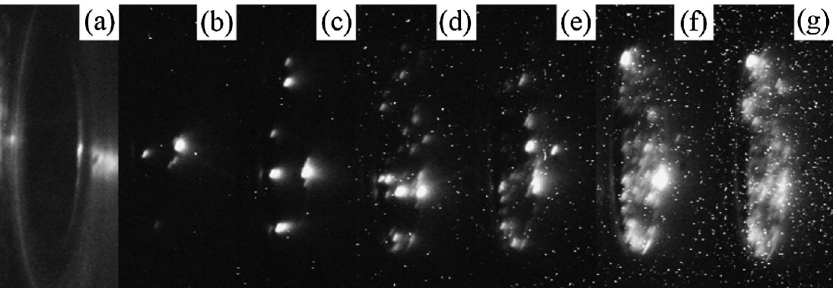
FIG. 3. CCD images: (a) background image of CNT cathode, (b)–(g) images of PFE of CNT cathode under diode voltages of 1.33– 1.64 MV.